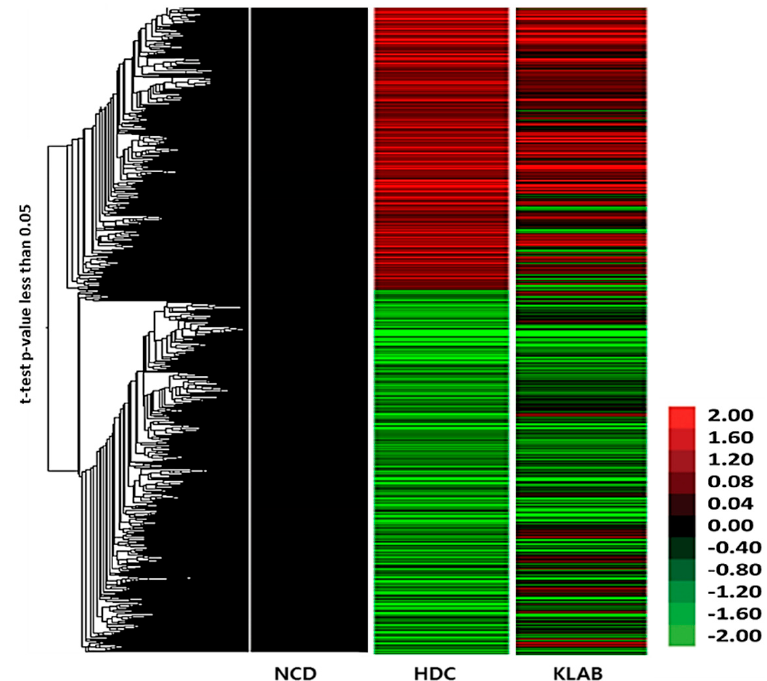
Figure 3. Histology of liver section. Histological examination (×100) in rat liver of (A) NDC (normal diet control group), (B) HDC (high-fat diet control group), (C) ORC (high-fat diet plus L-ornithine 20